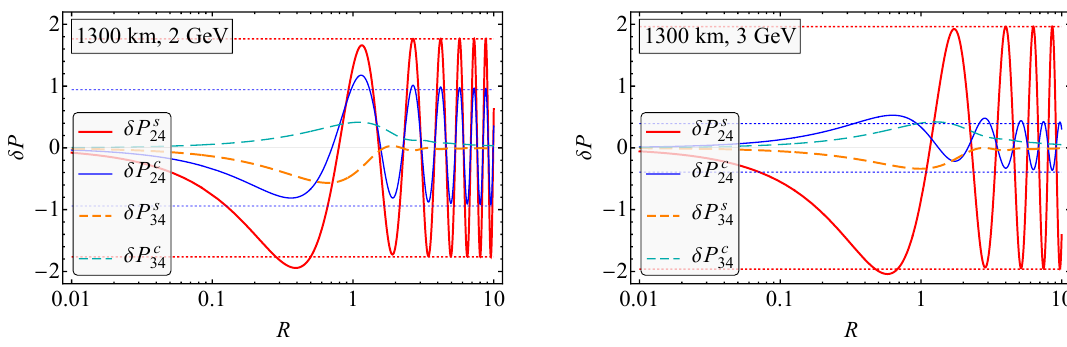
, at E = 2 GeV / ∆ m 2 ν 41 31